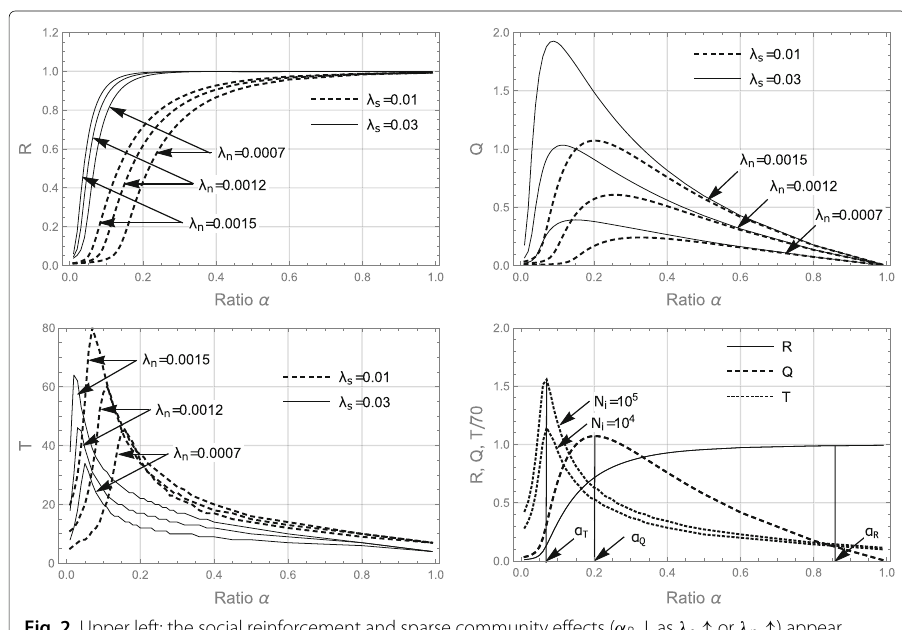
Fig. 2 Upper left: the social reinforcement and sparse community effects ( α R ↓ as λ s ↑ or λ n ↑ ) appear. Upper right: the structural trapping and sparse community effects ( α Q ↓ as λ s ↑ or λ n ↑ ) and “ Q (α Q ) ↑ as ↑ or λ ↑ ” hold. Lower left: the sparse community effect ( α λ s n ↓ ” hold. Lower right: relations “ α λ n lower left: N i = 10 4 . Lower right: N i = 10 4 ,10 5 , λ s = 0.01, and λ n = 0.0015. R and Q curves at N i = 10 4 in the lower right graph completely overlap with those at N i = 10